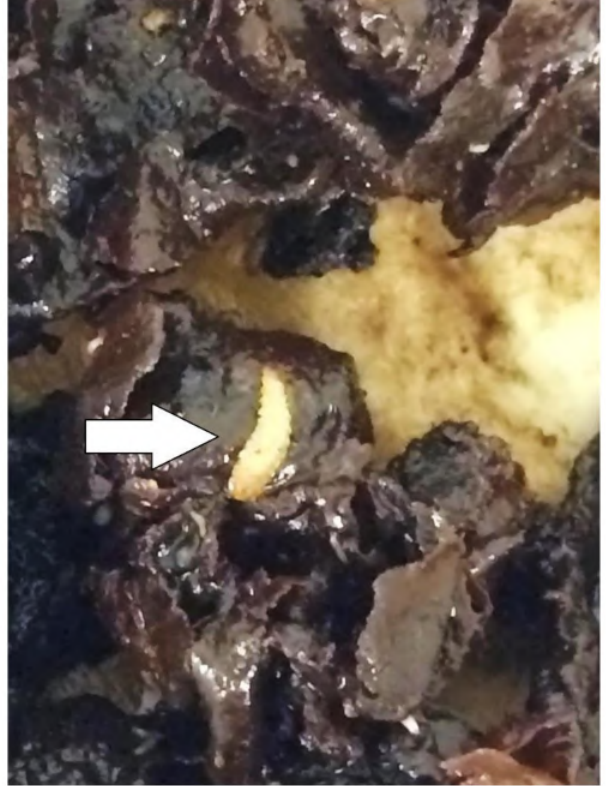
Figure 2. Larva of Hermetia sp. (white arrow) found on the decaying stingless bee nest of G. thoracica in Peninsular